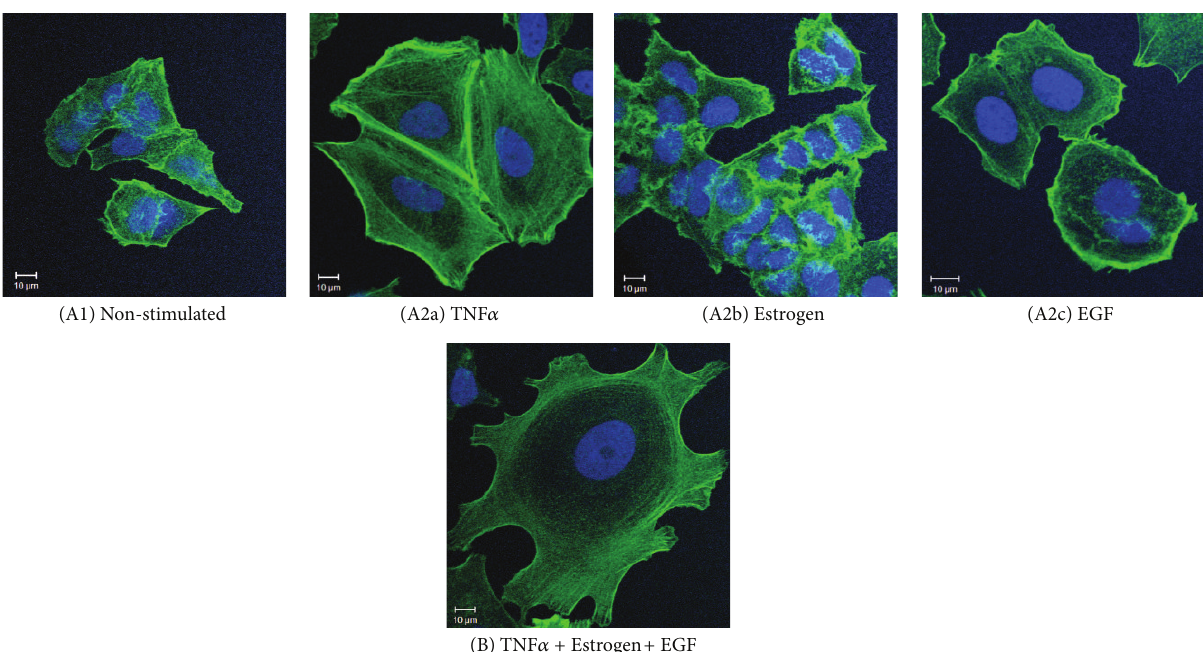
Figure 1: Combined stimulation by TNF 𝛼 + Estrogen + EGF induces extensive morphological changes and spreading in breast tumor cells. Breast tumor cells were either (A1) not stimulated (cells grown in the presence of diluents) or stimulated by (A2a) TNF 𝛼 (50ng/mL), (A2b) estrogen (10 −8 M), (A2c) EGF (30ng/mL), or (B) TNF 𝛼 + Estrogen + EGF (concentrations as above) for three days. The stimulatory conditions were selected following titration and kinetics analyses (data not shown). Actin filaments were detected by phalloidin staining (green) and cell nuclei by DAPI staining (blue). The cells were analyzed by confocal microscopy. In all panels, the results are from a representative experiment of 𝑛 ≥ 3